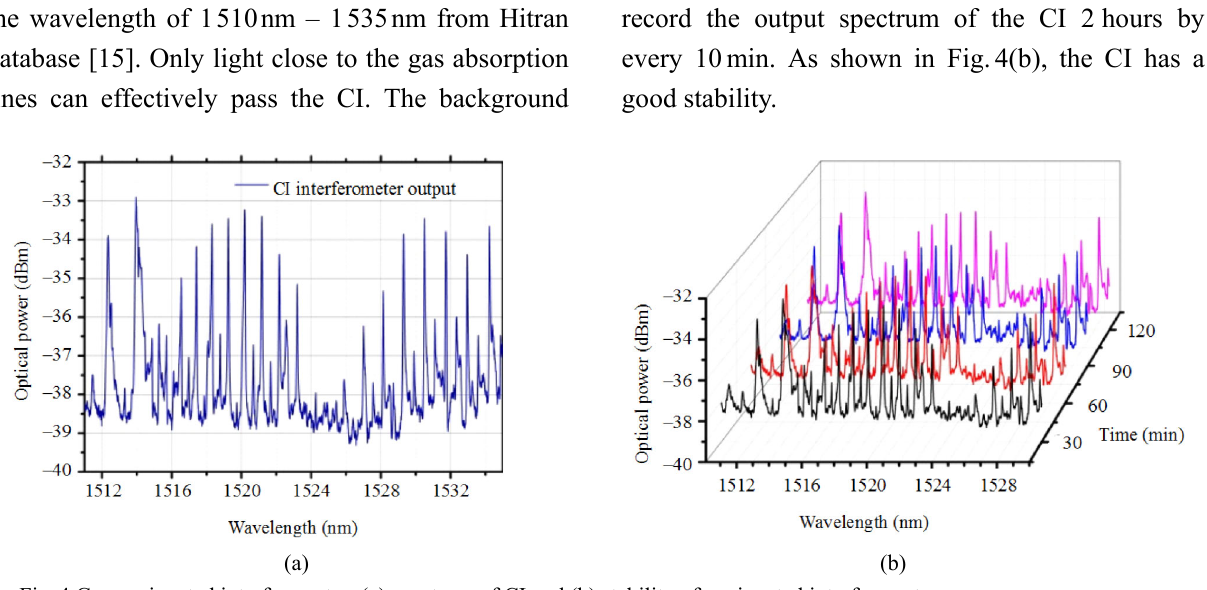
Fig. 4 Gas conjugated interferometer: (a) spectrum of CI and (b) stability of conjugated interferometer. 3.